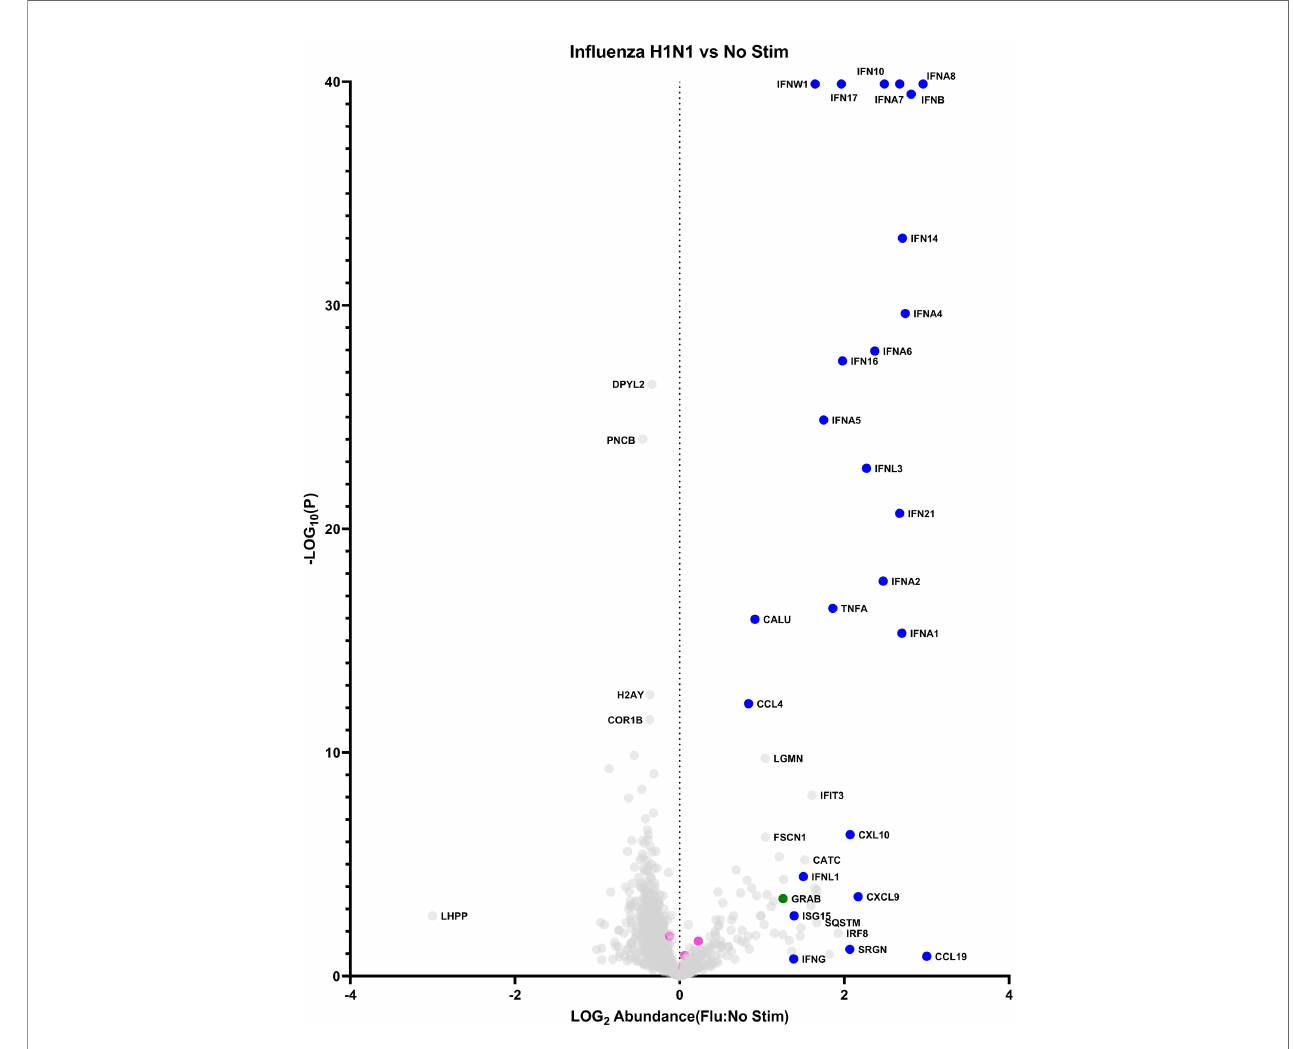
FIGURE 1 | The pDC secretome: baseline vs in fl uenza induced. Data points represent a single protein. Blue: cytokines/chemokines. Pink: exogenous proteins (bovine albumin, porcine trypsin, human transferrin). Green: granzyme